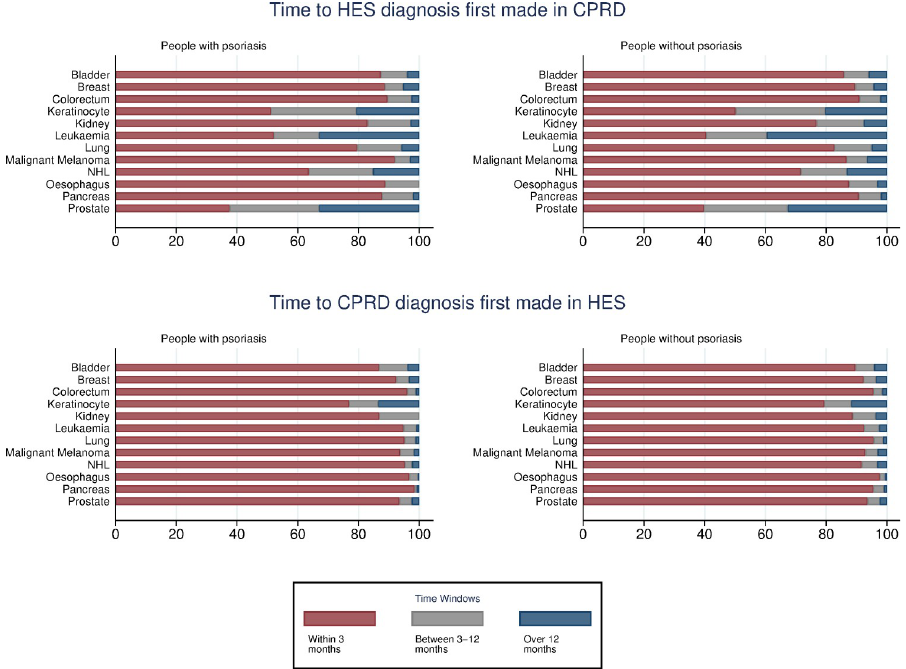
Fig 3. Delay between same site concordant record by cancer site for Aurum-linked